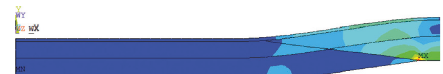
Figure 10: Structural dynamic stress of the infrastructure at a certain